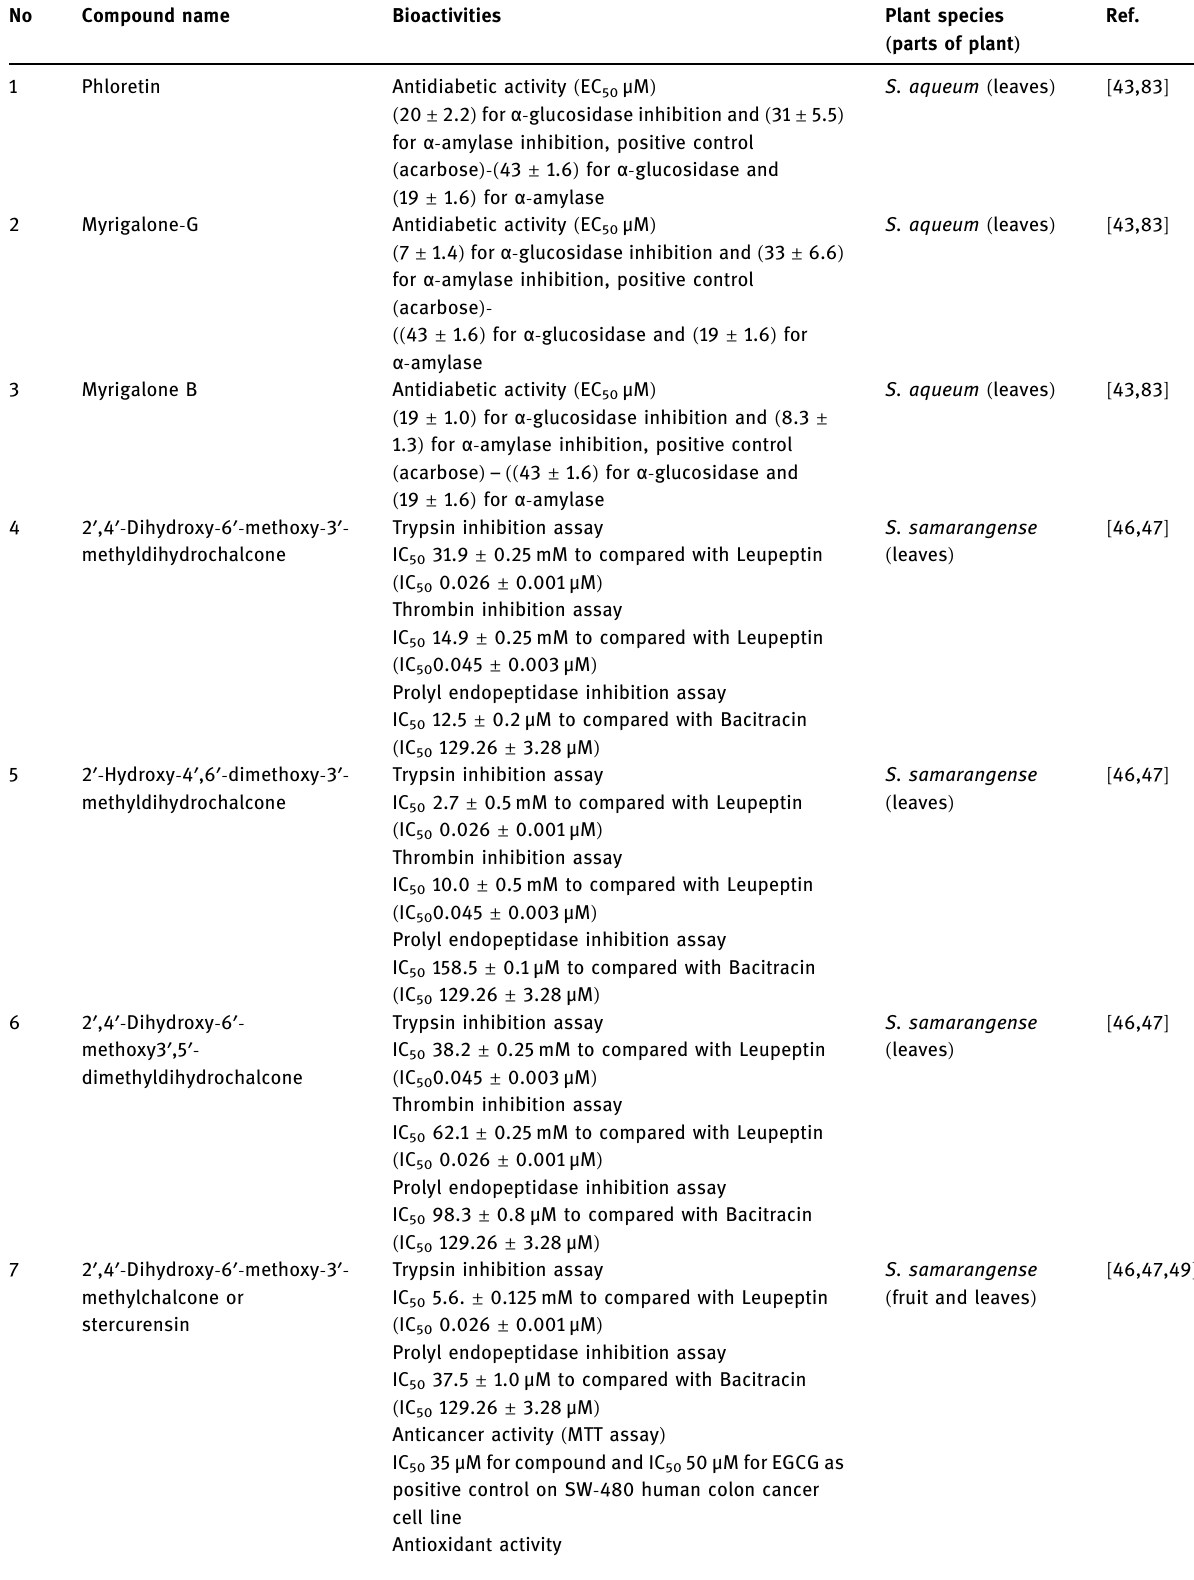
Table 2: Isolated compounds and their bioactivities reported from Syzygium